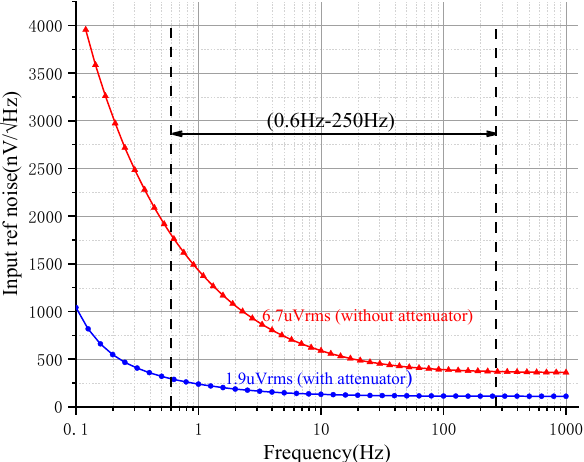
Figure 12. The input-referred noise of the ECG amplifier with and without attenuator.